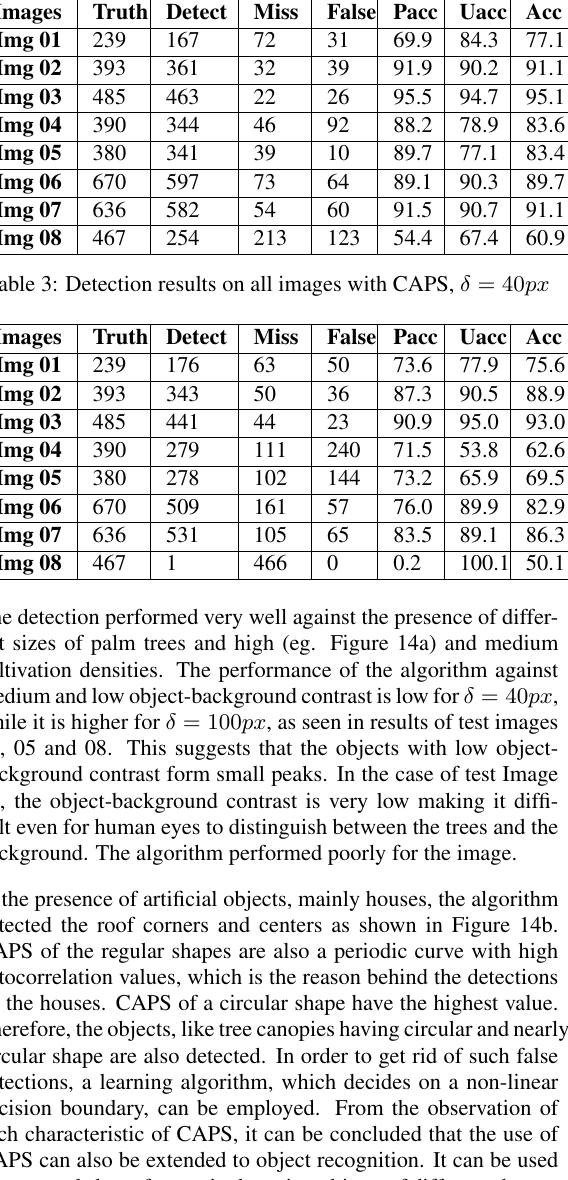
Table 2: Detection results on all images with CAPS, δ = 100 px Images